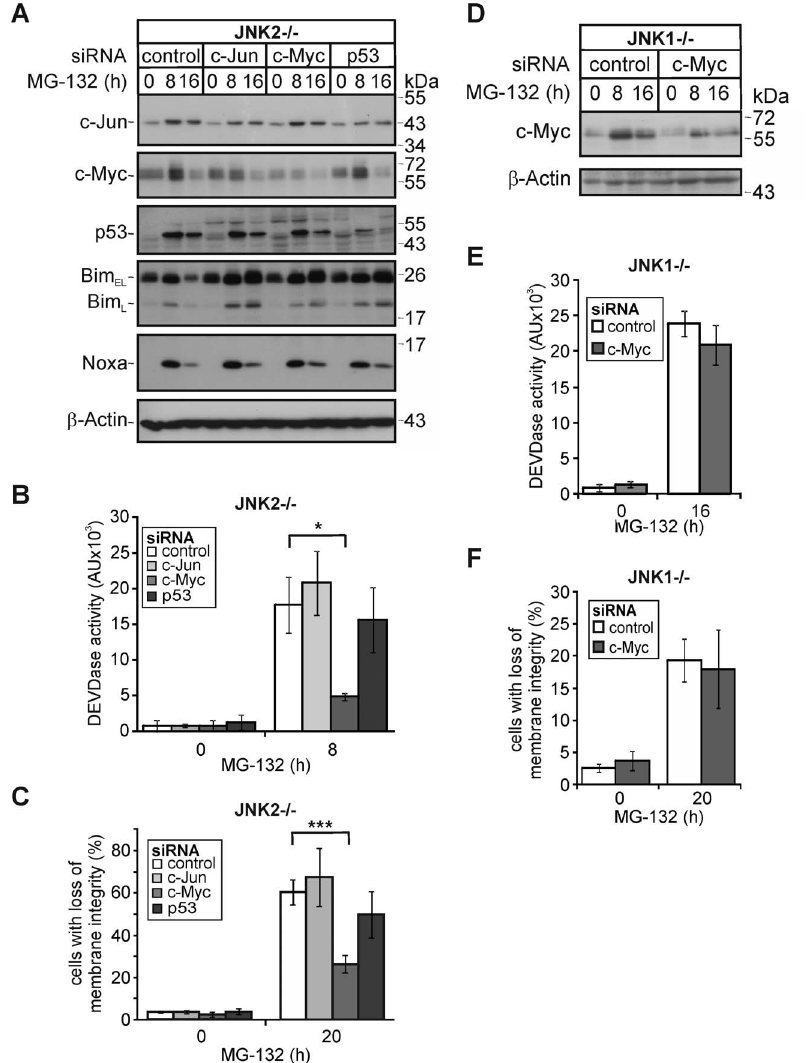
Figure 7. Knockdown of c-Myc protects JNK2 2 / 2 , but not JNK1 2 / 2 cells from MG-132-induced apoptosis without affecting expression of Noxa and Bim. (A, D) Western blots showing the status of the indicated proteins in JNK2 2 / 2 and JNK1 2 / 2 cells that were either left untreated or exposed for the indicated times to MG-132 72 hours post transfection with the indicated siRNAs. One representative experiment out of four and three is shown, respectively. (B, E) Fluorometric determination of caspase-3 (DEVDase) activities in JNK2 2 / 2 and JNK1 2 / 2 cells treated as described in A and D, respectively. Please note that DEVDase activities of JNK2 2 / 2 and JNK1 2 / 2 cells were analyzed at different time points (8 h and 16 h) according to their sensitivities. Values are the mean of three independent experiments + / 2 SD, respectively. (C, F) Cytometric determination of cell death (propidium iodide uptake) in JNK2 2 / 2 and JNK1 2 / 2 cells treated as described in A and D. Values are the mean of three independent experiments + / 2 SD. * p , 0.05 according to ANOVA on ranks Student-Newman-Keuls-Method (B) or *** p , 0.003 according to ANOVA Tukey 9 s test (C) in an all pairwise multiple comparison as indicated.